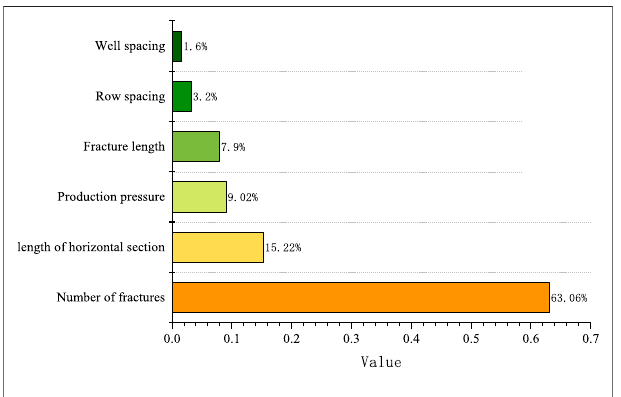
FIGURE 12 | Range analysis diagram of engineering sensitivity parameters results.